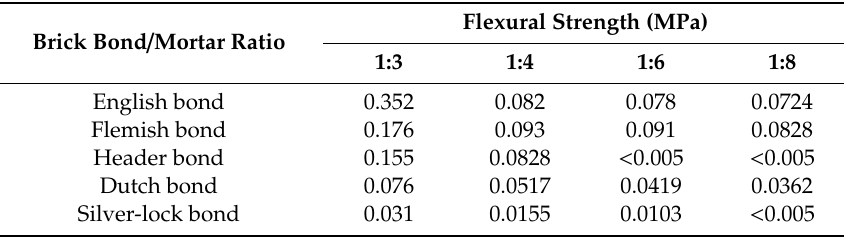
Table 7. Flexural strength (MPa) of di ff erent brick masonry